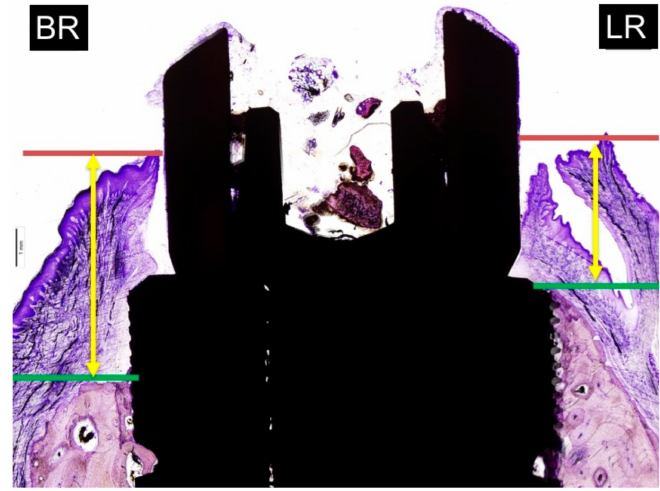
Figure 6. Measurements of soft tissue thickness: BR: buccal crest resorption (distance from the top of the implant shoulder to the first BIC in the buccal crestal side. LR: lingual crest resorption (distance from the top of the implant shoulder to the first BIC in the lingual crestal